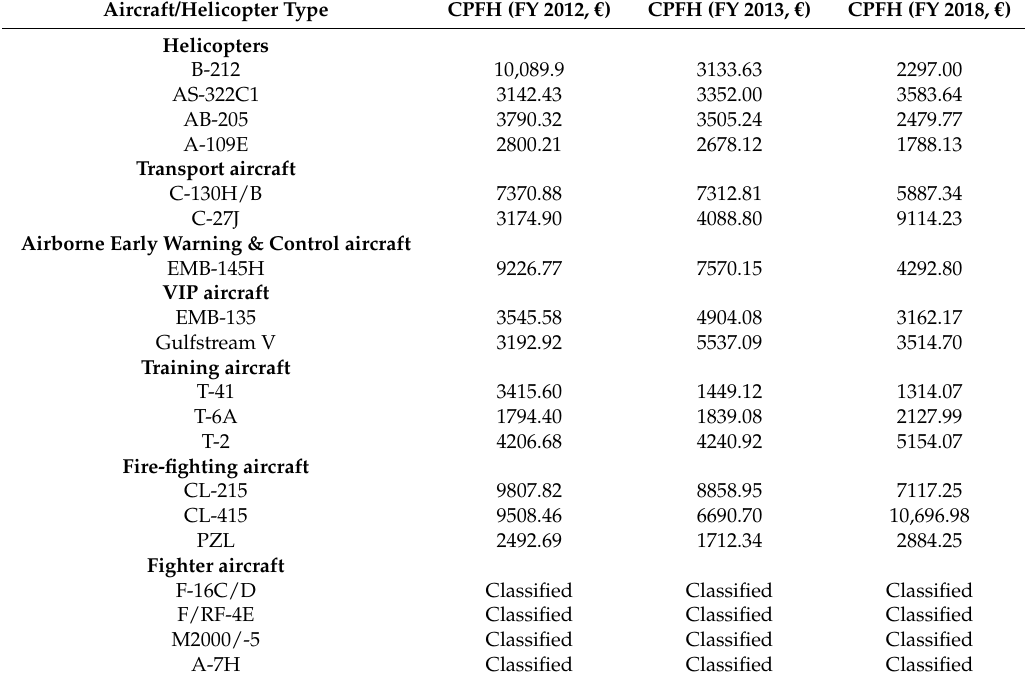
Table 1. HAF fixed and rotary wing aircraft types used for the development of the parametric model and related CPFH data for FY 2012, 2013 and 2018. (CPFH data for fighter aircraft is classified-publication is restricted. It includes the contribution of the ‘indirect support’ cost category. Data retrieved by various published issues of the Official Governmental Gazette of Greece